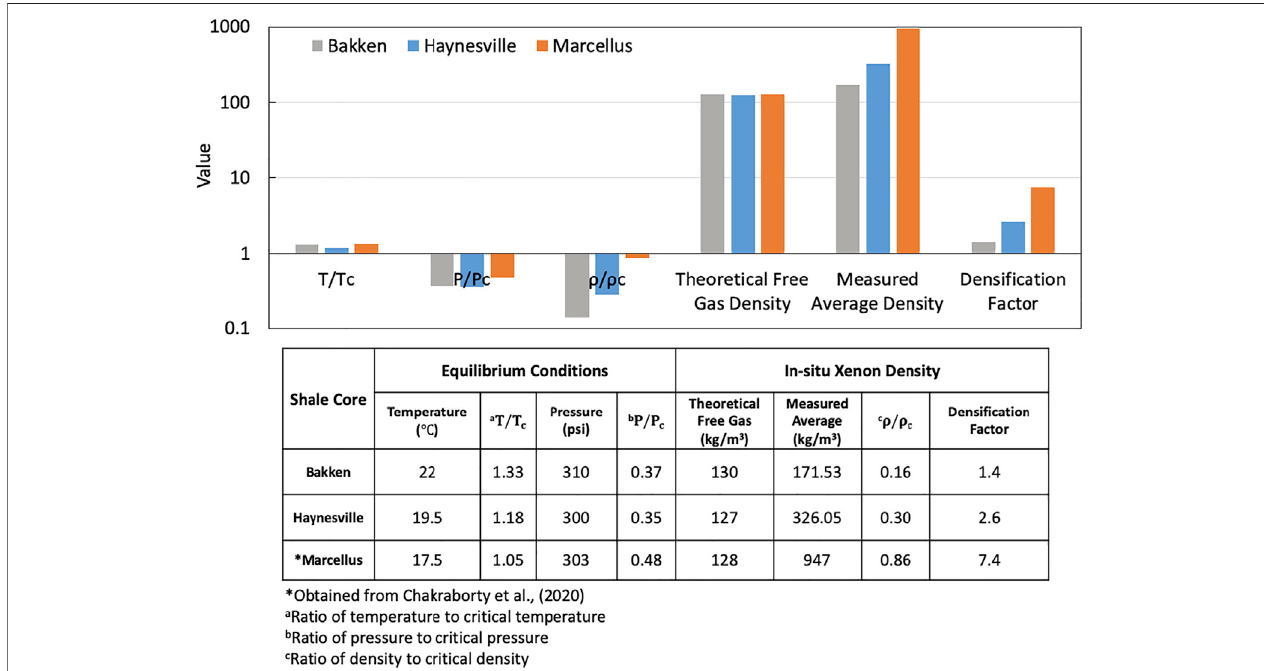
FIGURE 6 | Summary of the gas invasion experiments on the Bakken, Haynesville and Marcellus samples.